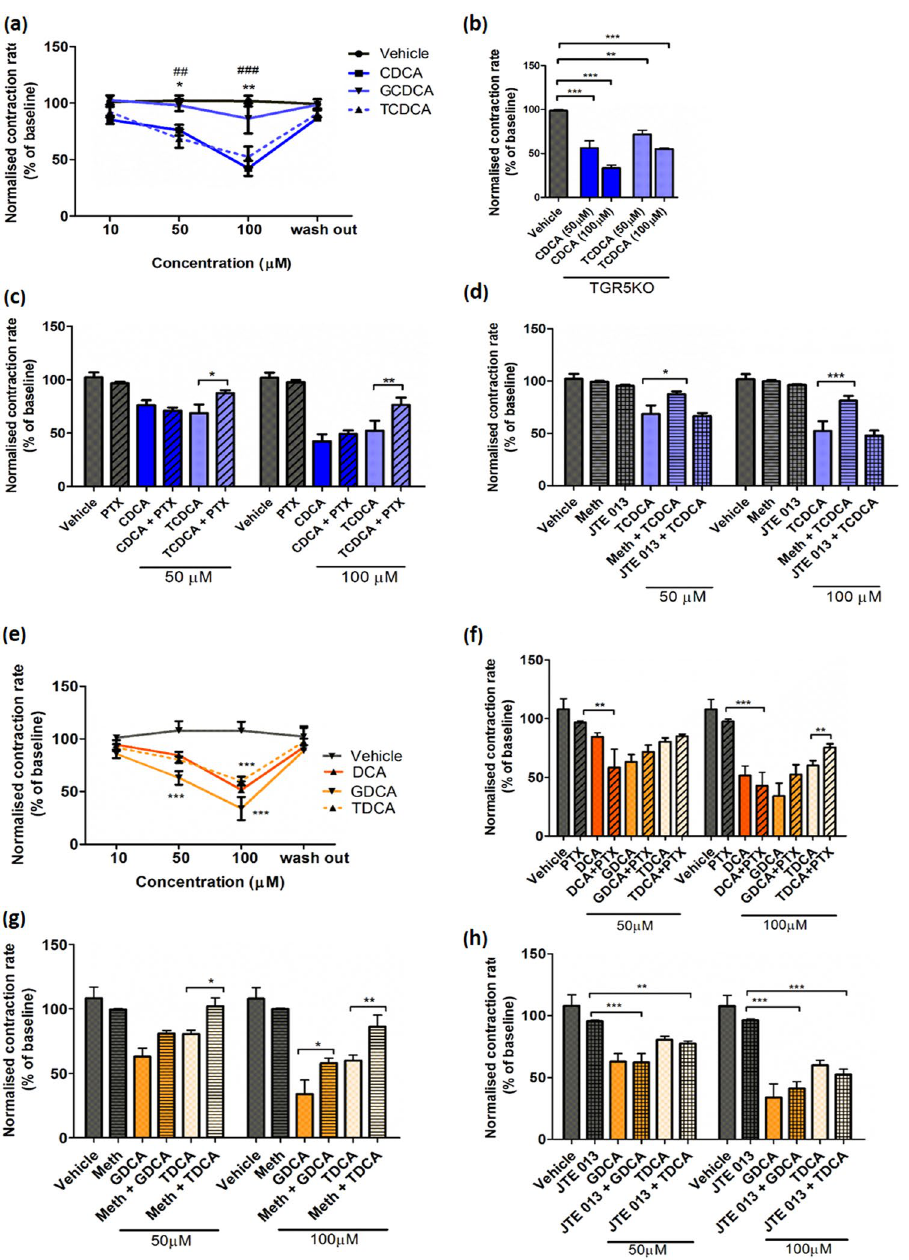
Figure 6. Dose-dependent reduction of contraction rate of NRVMs by conjugated bile acids depends on Gi signalling and muscarinic M2 receptor. ( a ) Contraction rate of WT NRVMs following treatment with CDCA and its conjugates at 10–100 μ M (n = 6, * p < 0.05, ** p < 0.01); (b) Contraction rate of WT and TGR5KO NRVMs following treatment with CDCA and TDCA at 50 and 100 μ M (n = 5, ** p < 0.01, *** p < 0.001); ( c ) Contraction rate of NRVMs with and without pretreatment with 1 µ g/ml PTX followed by treatment with CDCA and TCDCA at 50 and 100 μ M (n ≥ 5, * p < 0.05, ** p < 0.01); ( d ) Contraction rate of NMVMs with and without pretreatment with either 1 µ M methoctramine (M2 antagonist) or 10 µ M JTE013 (S1P2 antagonist) followed by treatment with CDCA and TCDCA at 50 and 100 μ M (n = 5, * p < 0.05, ** p < 0.01); ( e ) Contraction rate of NMVMs following treatment with DCA and its conjugates at 10–100 μ M (n = 6, * p < 0.05, ** < 0.01, two-way ANOVA with Benferroni post-hoc analysis). (f) Contraction rate of NMVMs with and without pretreatment with 1 µ g/ml PTX followed by treatment with DCA and its conjugates at 50 and 100 μ M (n ≥ 5, * p < 0.05, ** p < 0.01, two-way ANOVA with Benferroni post-hoc analysis); ( g ) Contraction rate of NMVMs with and without pretreatment with 1 µ M methoctramine (M2 antagonist) followed by treatment with GDCA and TDCA at 50 and 100 μ M (n ≥ 5, * p < 0.05, ** p < 0.01, two-way ANOVA with Benferroni post-hoc analysis. ( h ) Contraction rate of NMVMs with and without pretreatment with 10 µ M JTE013 (S1P2 antagonist) followed by treatment with CDCA and TCDCA at 50 and 100 μ M (n ≥ 5, * p < 0.05, ** p < 0.01, two-way ANOVA with Benferroni post-hoc